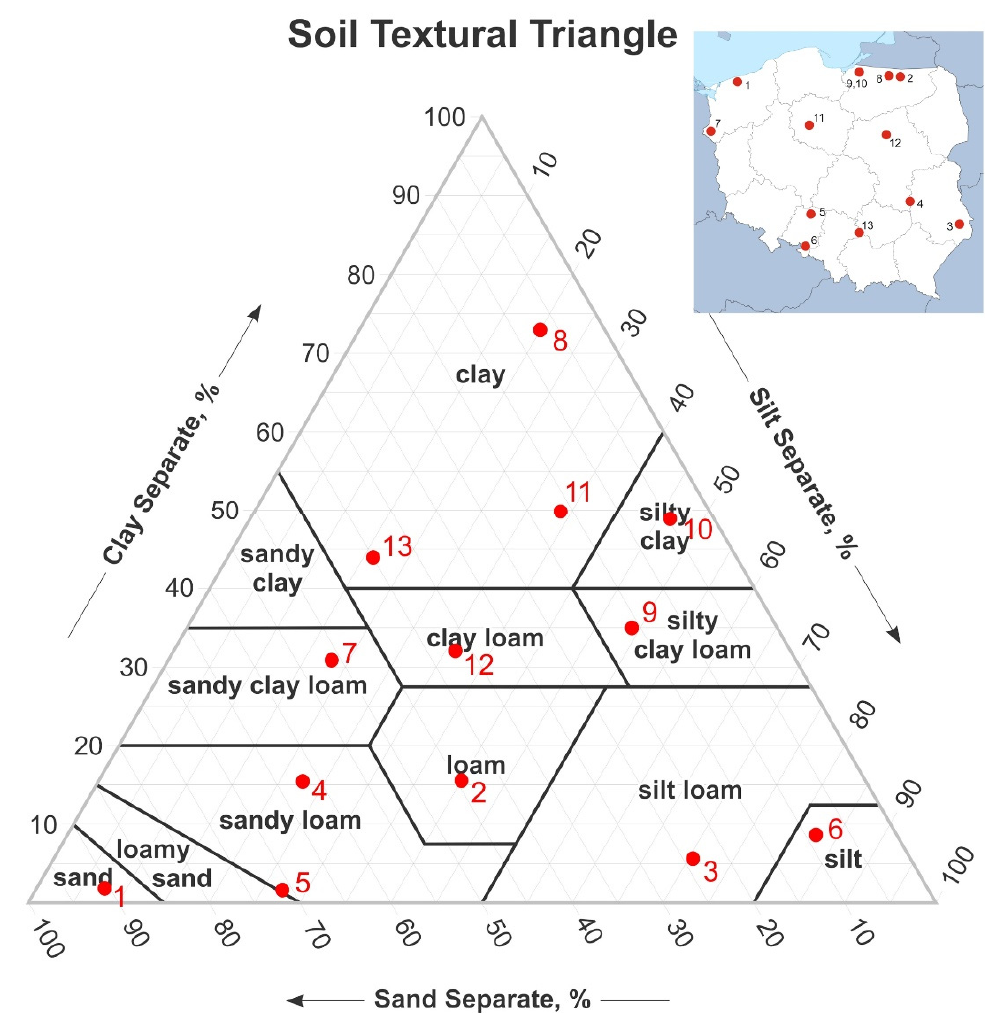
Figure 1. Sampling sites map and graphical representation of which particular texture groups soil samples belong to. PSD, which was the basis for this classification, was measured using the hydrometer method.